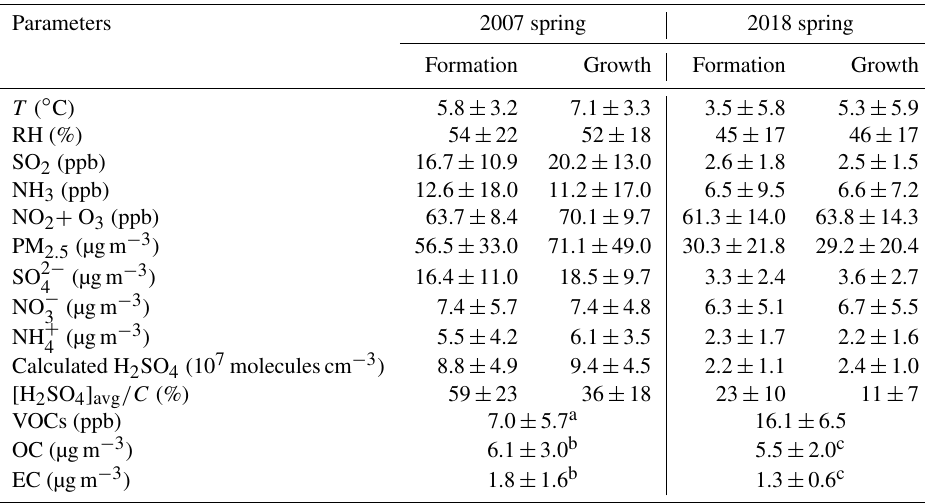
Figure 5. Campaign average of SO 2 mixing ratios (average during NPF periods, a ), CS (1h prior to NPF events, b ), NO 2 + O 3 (average during new particle growth periods, c ), and NPF event durations (d) during the seven observation campaigns. The error bars are the standard deviations. Table 2. Meteorological conditions and air pollutants during the formation and growth periods of new particles in the spring campaigns in 2007 and